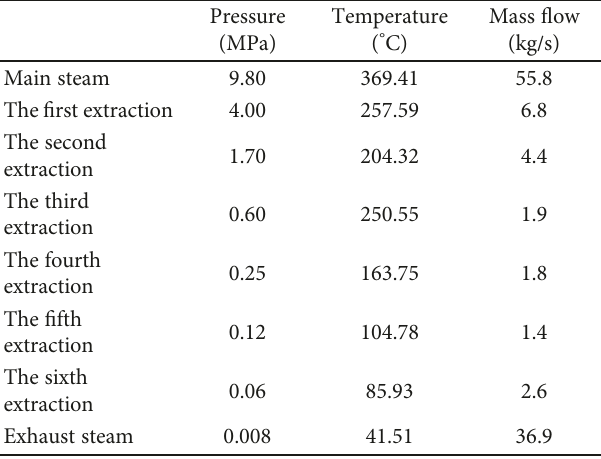
Figure 1: CSP-PV hybrid power system. Table 1: Main parameters of power